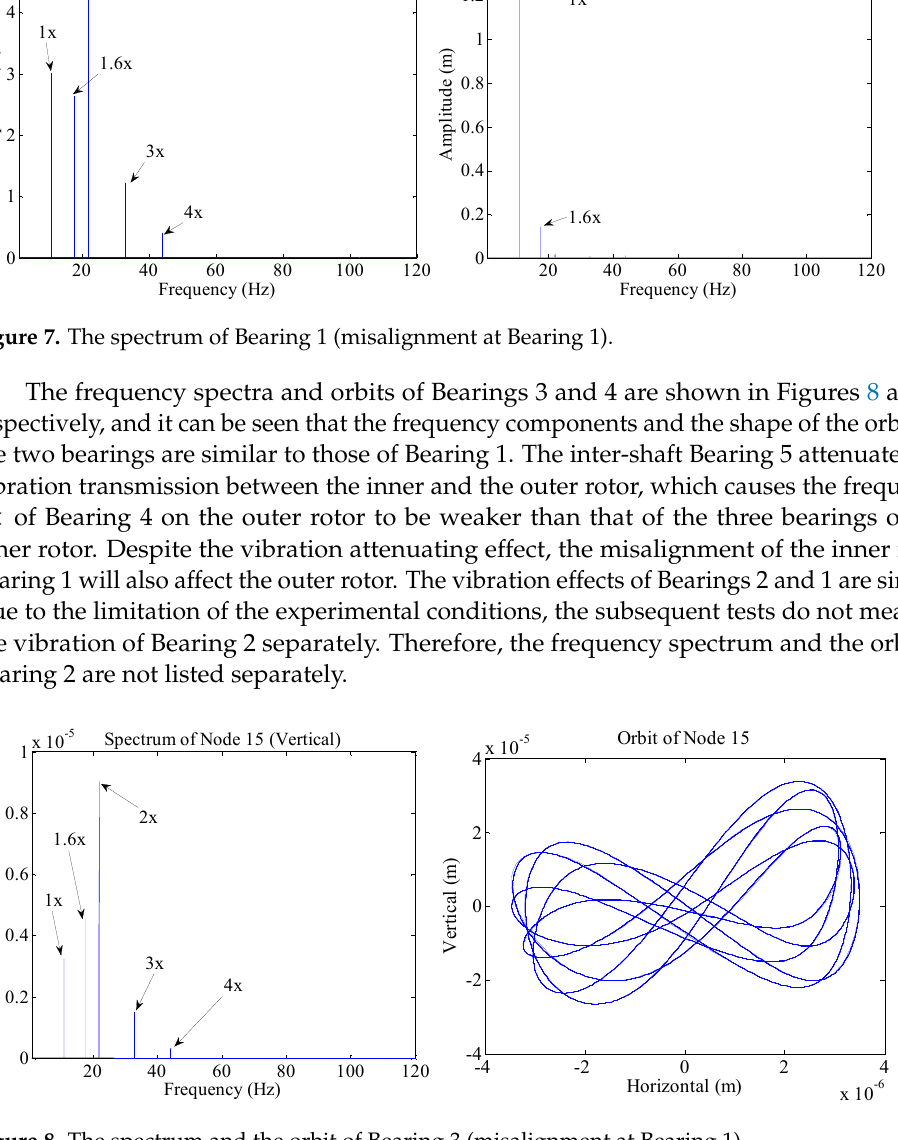
Figure 9. The spectrum and the orbit of Bearing 4 (misalignment at Bearing 1). 3.2. Effects of Supporting Misalignment at Bearing 3 In the coupling misalignment model [26], it shows that the supporting misalign- ment of Bearing 3 has no effect on the rotor system because the bearing elevation of Bearing 3 causes no misalignment in the coupling. This is inconsistent with the actual test results, which are discussed in Section 4. Therefore, the coupling model can only ex- plain the impact of the supporting misalignment of Bearings 1 and 2 on the dynamic characteristics of the rotor system, while the model of bearing supporting misalignment can fill up the defect. Supposing the supporting misalignment occurs at Bearing 3, the orbits and vertical spectra of Bearings 1, 3, and 4 are shown in Figures 10–12, respectively. The figures show that the impact of the supporting misalignment of Bearing 3 and that of Bearing 1 on the frequency components of the rotor system are basically the same. The frequency spectrum is also dominated by 1×, 1.6×, and 2×. Although 3× and 4× are also aroused, these two frequencies are relatively weak. The differences of misalignment effects of Bearings 1 and 3 can be drawn as follows: (1) The amplitude of 2× caused by the misalignment of Bearing 3 is smaller than that of Bearing 1. The vibration caused by the misalignment of Bearing 1 is more severe when Bearings 1 and 3 have the same degree of misalignment. In other words, the coaxi- al dual-rotor system is more sensitive to misalignment at Bearing 1, which may be due to the smaller bearing load generated by Bearing 3 under the same misalignment. (2) The orbit is in the shape of a “reticulate spindle” when Bearing 3 is misaligned. However, the 8-shaped orbit is often regarded as a typical feature of misalignment, which is similar to the orbit when Bearing 1 is misaligned. This may be due to the small- er 2× amplitude.